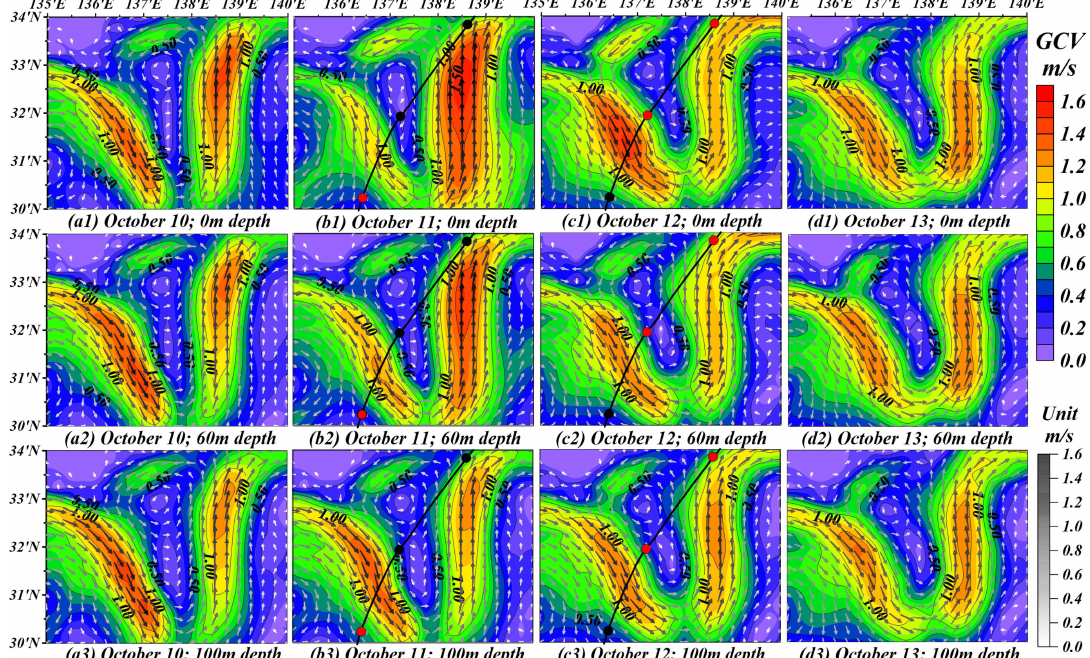
Figure 7. Kuroshio current velocity (m/s) on the boundary of longitude 135–140 ◦ E and latitude 30–34 ◦ N based on depth and date; 0 m ( a1 , b1 , c1 , d1 ), 60 m ( a2 , b2 , c2 , d2 ), and 100 m ( a3 , b3 , c3 , d3 ) on 10, 11, 12, and 13 October, respectively. The figures are focused on the strong cyclonic eddy area with